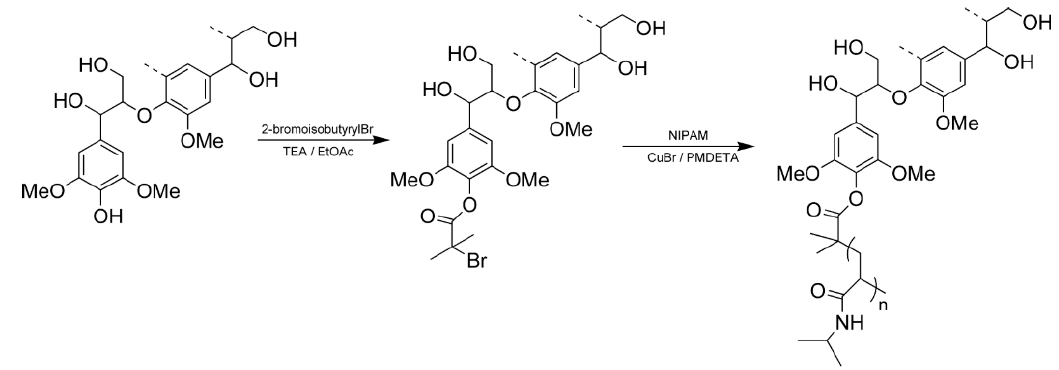
Figure 15. Scheme for the Preparation of Lignin- g -polyN-isopropylacrylamide (NIPAM) Copolymers